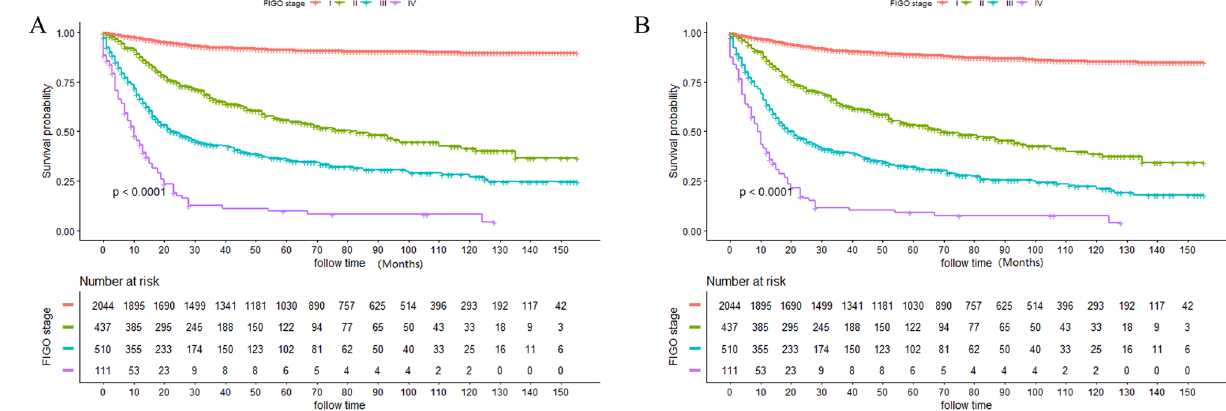
Figure 2. Kaplan–Meier curves stratified by FIGO stage of CSS ( A ) and OS ( B ). Cancer ‐ specific Grade Number